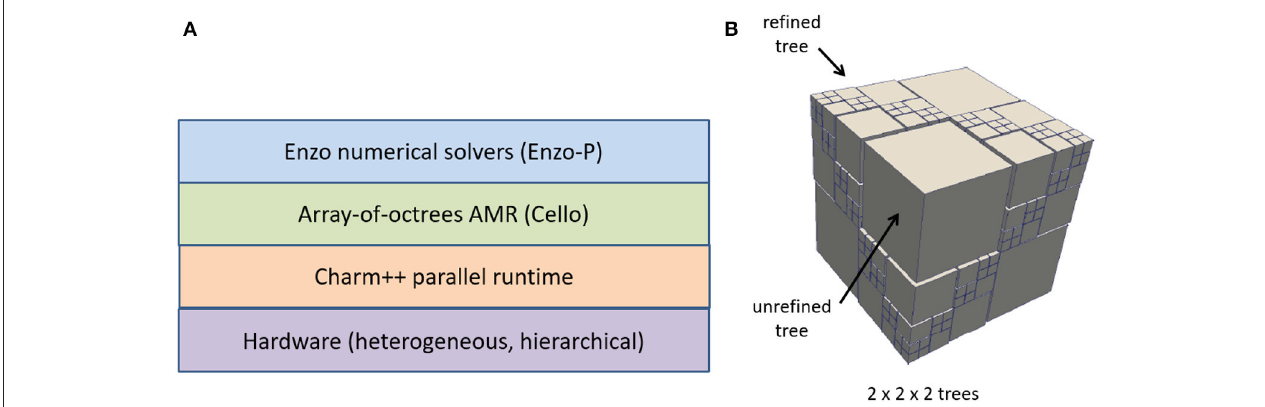
FIGURE 12 | (A) Layered software architecture of the Enzo-P/Cello extreme scale hydrodynamic cosmology code. (B) Schematic illustration of the array-of-octree approach for adaptive mesh refinement used in